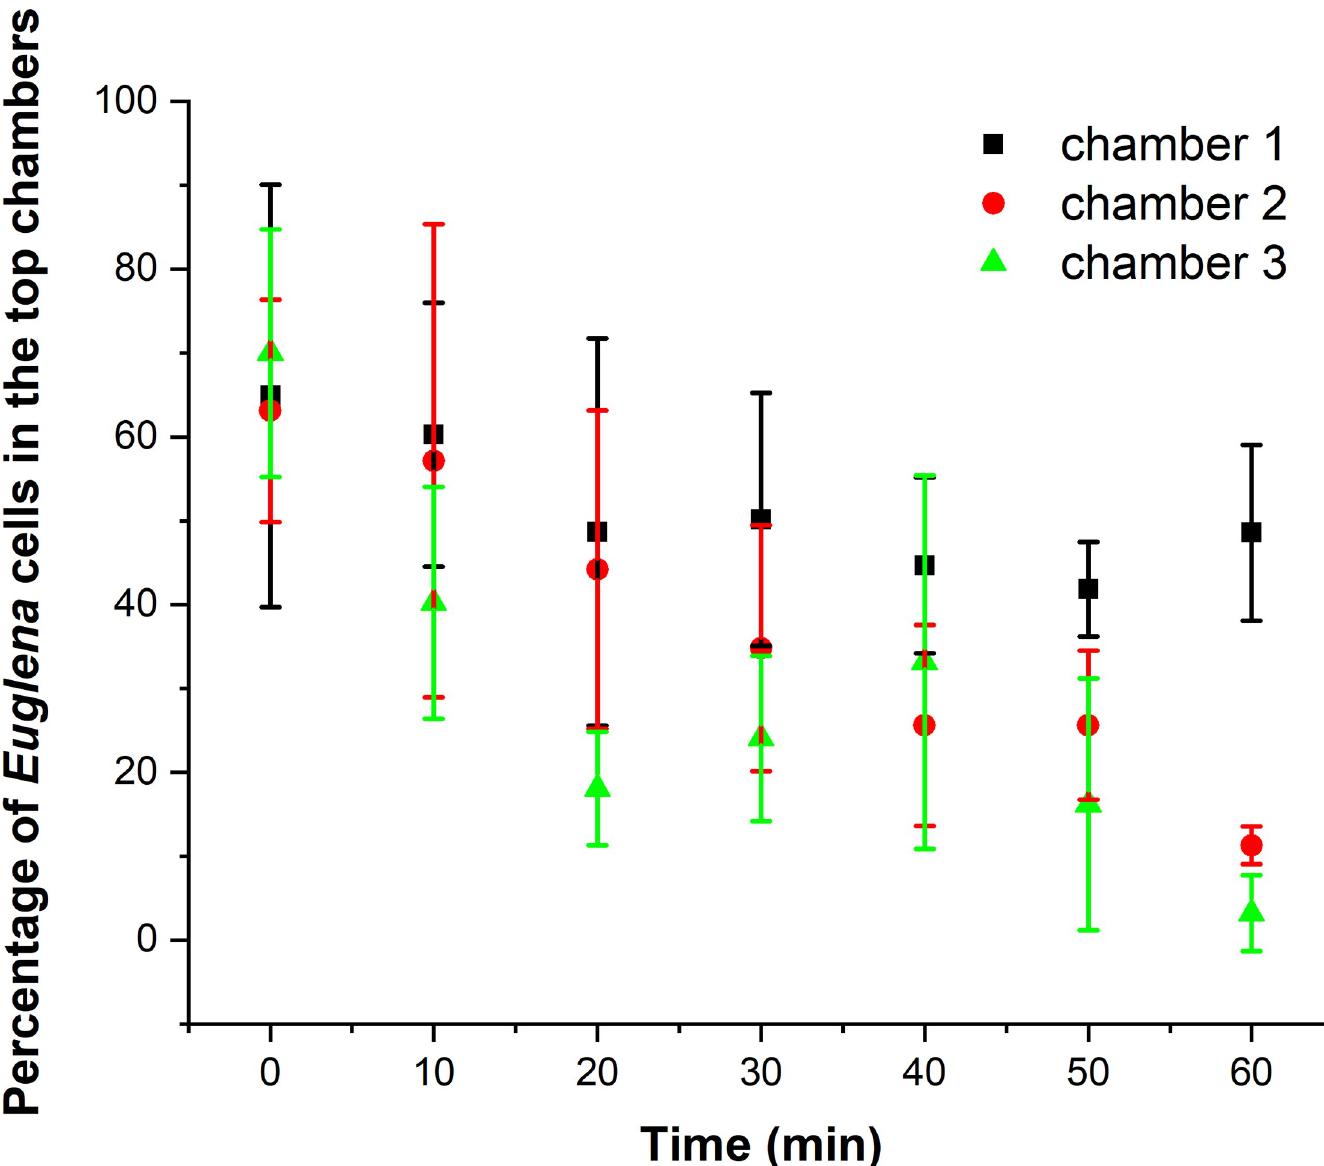
Fig 7. Euglena distribution (percent of total observed cells over time from initiation of experiment) inside the microfluidic chambers with the bottom side channel filled with Listeria suspension.